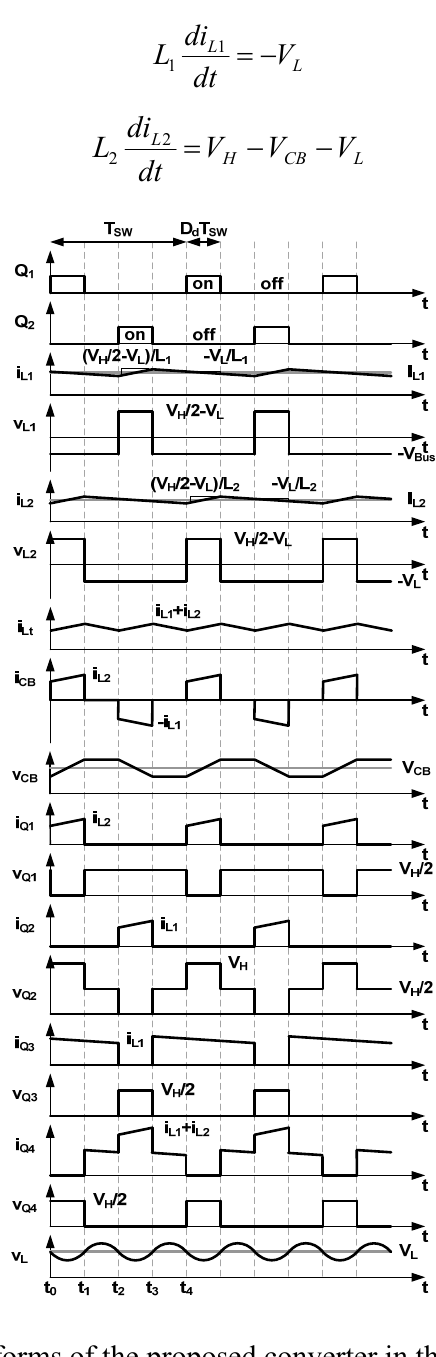
Figure 4. Typical waveforms of the proposed converter in the charge mode